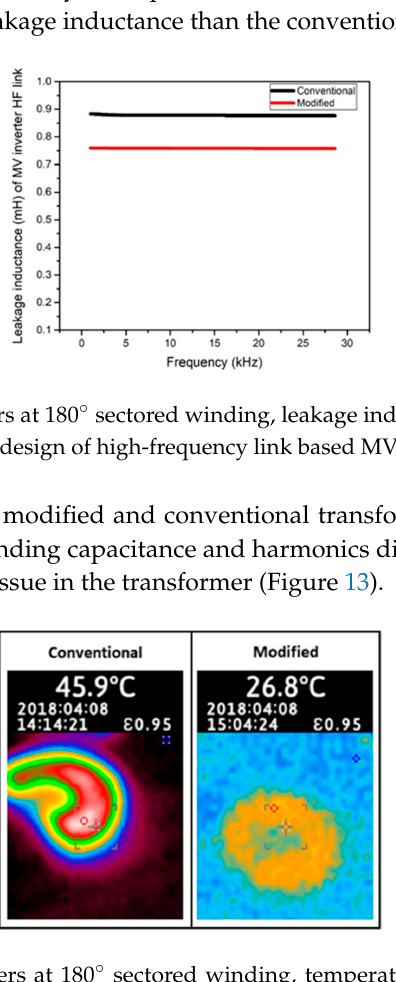
conventional and modified transformer design.